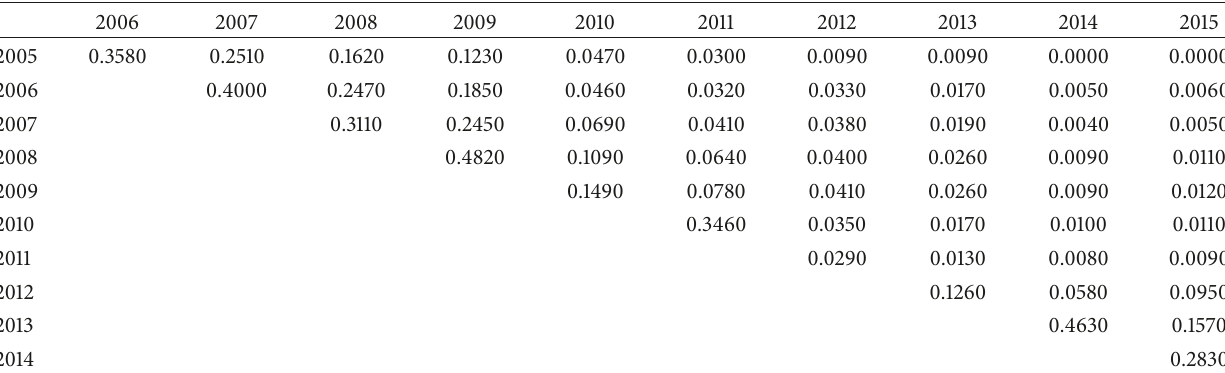
Table 3: Jaccard similarity of the GUG network over